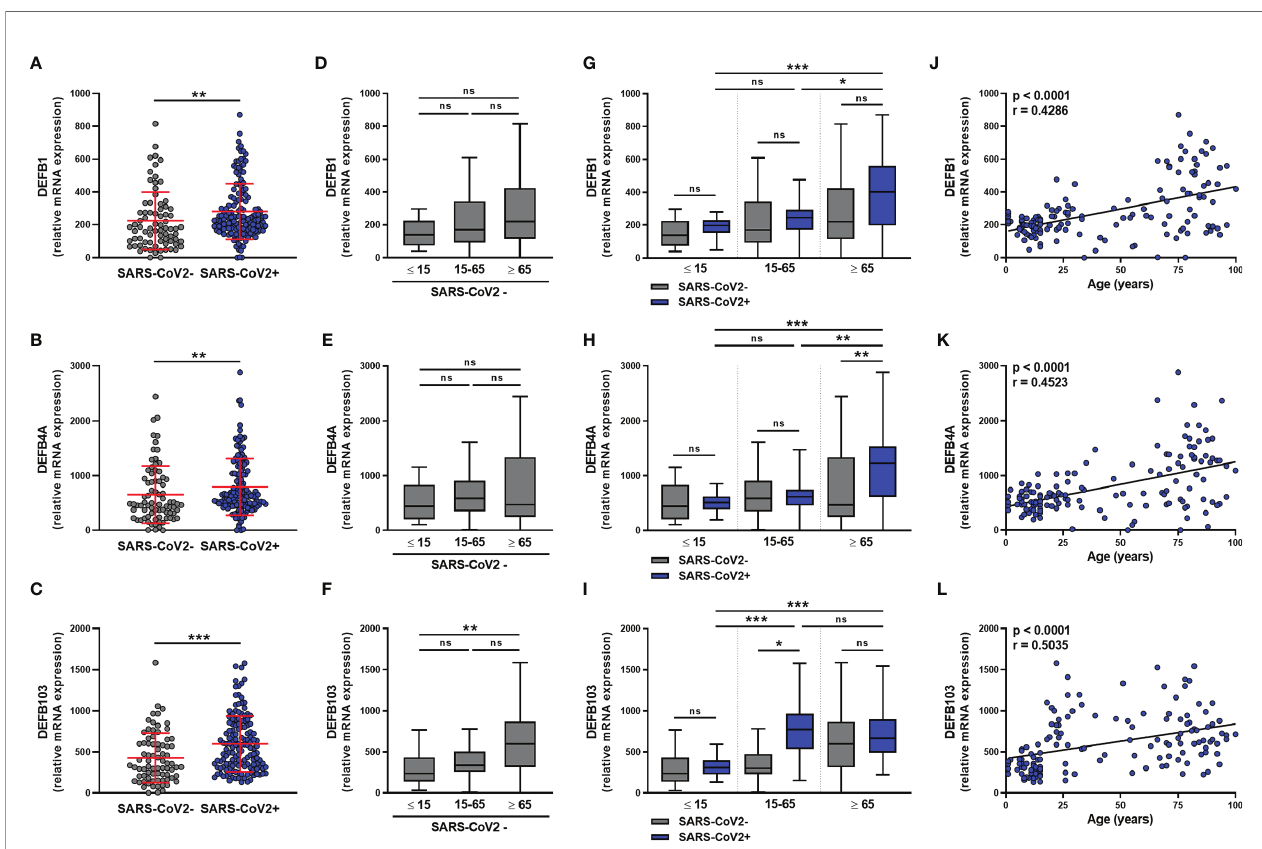
FIGURE 4 | b -defensins transcript levels are differentially increased in SARS-CoV-2-positive patients. hBD1 ( DEFB1 ), hBD2 ( DEFB4A ), and hBD3 ( DEFB103 ) mRNA levels was determined by RT-qPCR in nasopharyngeal samples from SARS-CoV-2-infected (n=147) or non-infected (n=79) individuals. Data from the two groups are compared as a whole (A – C) , or according to the age of individuals: < 15 years old, 15-65 years old and > 65 years old (D – I) . hBD1-3 transcript levels and age were correlated (J – L) . Each symbol represents a single individual. Boxplots represent the median and 25th to 75th percentiles and the whiskers denote the maximum and minimum values. Data are compared using Mann-Whitney (A – C) , Kruskal-Wallis test followed by Dunn ’ s multiple comparison test (D – I) , or Spearman ’ s correlation (J – L) .*p < 0.05, **p < 0.005, ***p < 0.001. ns, not signi fi